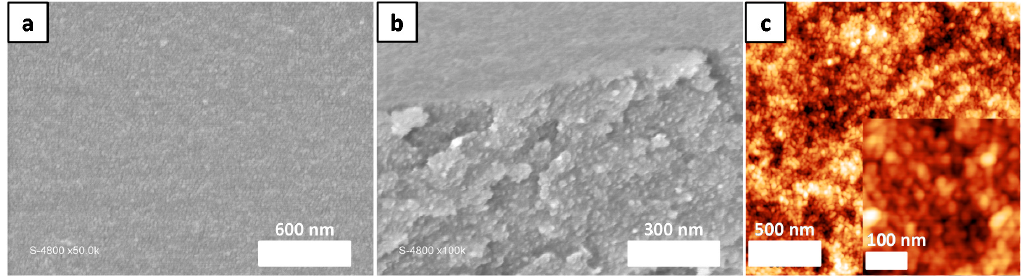
Figure 4. SEM images of the top surface ( a ) and cross section ( b ) of the support membrane coated with micellar solution of PS 10K -PNaSS 10K -PS 10K in DMF/water mixture. ( c ) AFM image showing the spherical micelle assembly.